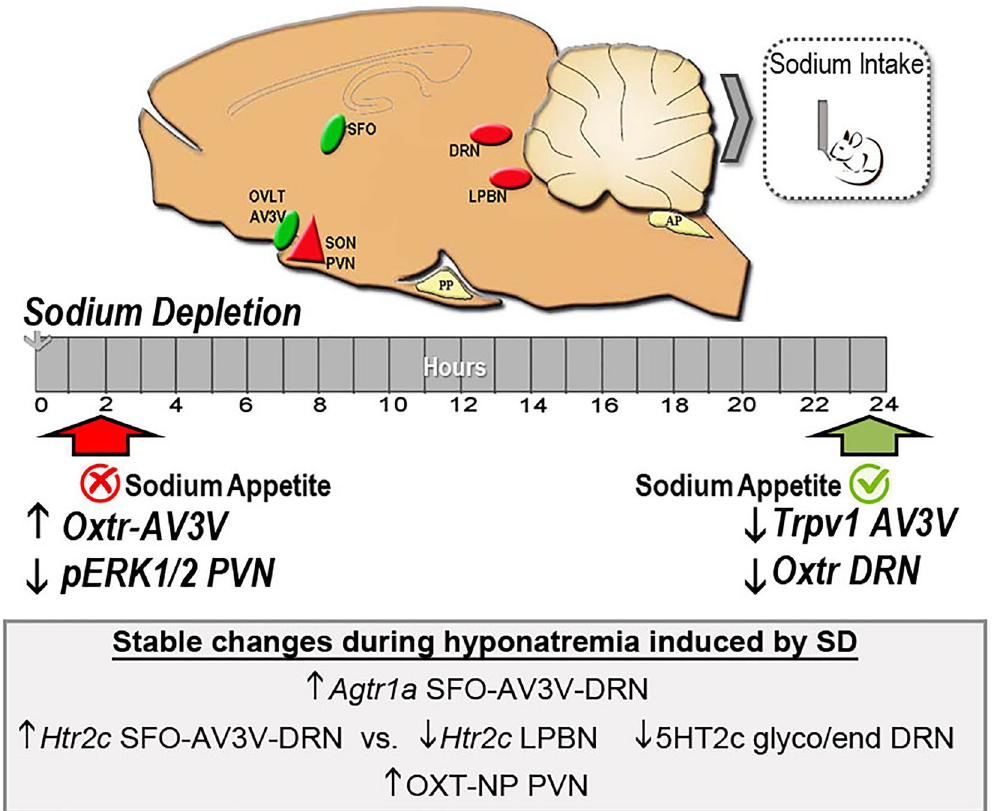
Figure 8. Multi-system, integrated responses after sodium depletion. After sodium depletion the expression of critical components within the brain control circuit of sodium appetite, including Angiotensin-type-1 receptor, Oxytocin-neurophysin-I, and serotonergic-(5HT)-type-2c receptor were changed regardless of time (grey box). When sodium appetite is inapparent, at two hours after SD, there is reduced MAPK phosphorylation in the PVN and increased Oxtr mRNA expression in the AV3V. At twenty-four hours after SD, when sodium appetite is released, there is a reduction of Trpv1 and Oxtr mRNA expression in the AV3V and dorsal raphe nucleus, respectively. The results indicate that SD exerts a plastic temporally coordinated effect to promote the onset of sodium appetite and restore water-electrolyte homeostasis. DRN: dorsal raphe nucleus, LPBN: lateral parabrachial nucleus, SON: supraoptic nucleus, PVN: paraventricular nucleus, OVLT: oraganum vasculosum of the lamina terminalis; AV3V: anteroventral third ventricle area; SFO: subfornical organ, pERK: phosphorilated extracellular signal-regulated kinase, Agtr1a: angiotensinerigic receptor type 1 gene, Trpv1: Transient receptor potential vanilloid subtype 1 gene. Oxtr: oxytocin receptor gene, Htr2c: serotonergic receptor type 2c gene, OXT-NP: Oxytocin + neurophysin, 5HT2C glyco/endo: glycosilated serotonergic receptor type